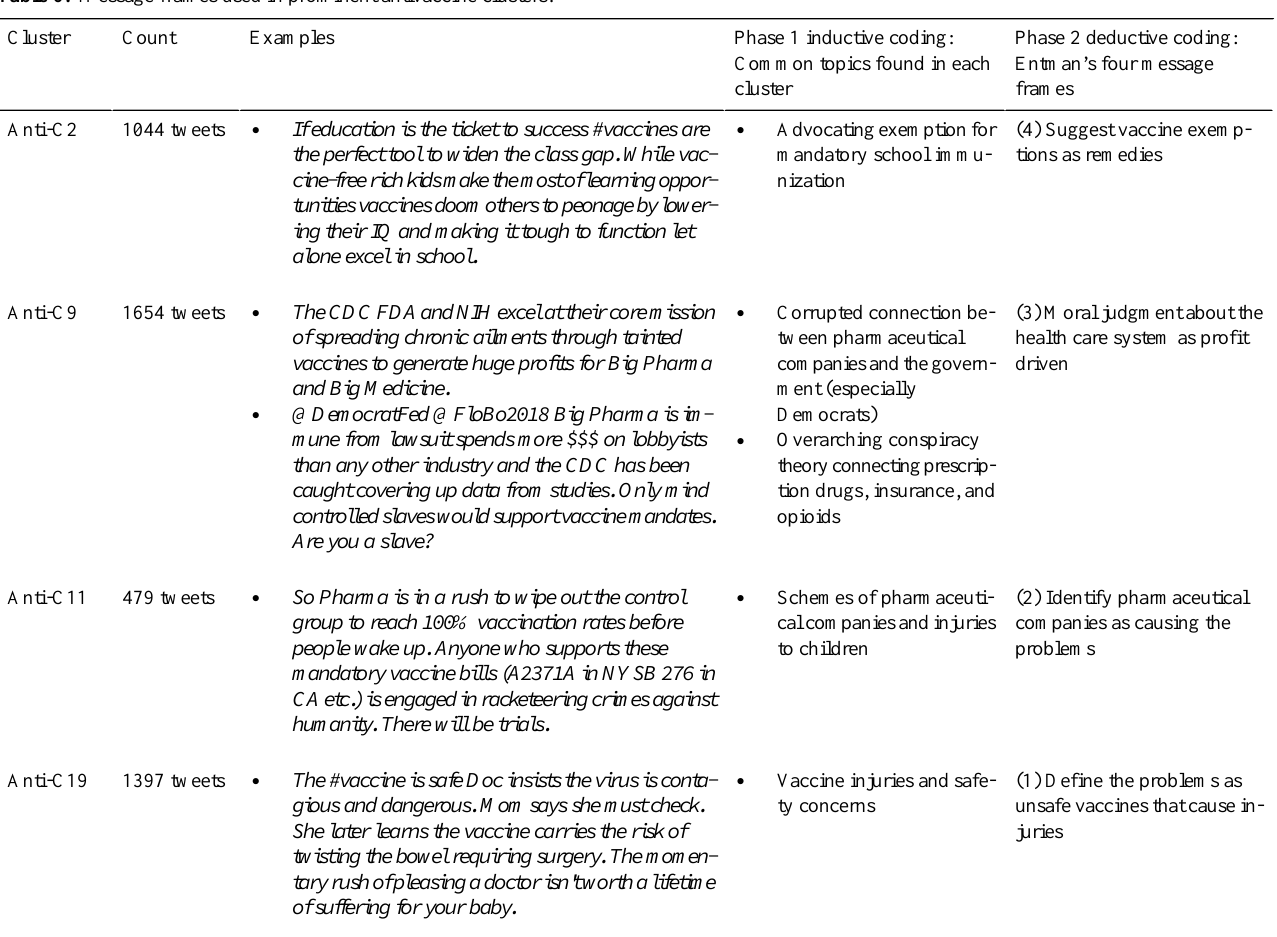
Table 6. Message frames used in prominent antivaccine clusters.